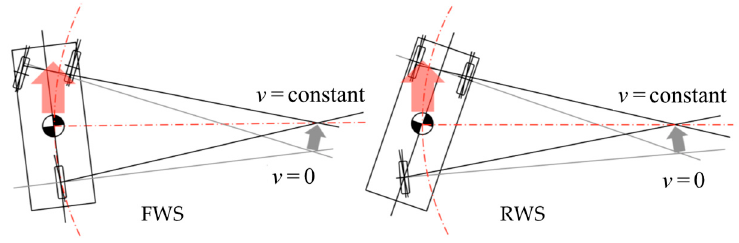
Figure 17. Vehicle postures on steady-state cornering.